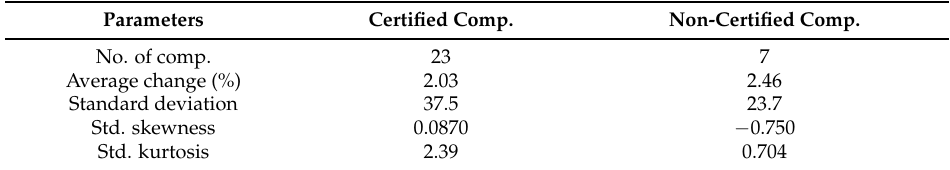
Table 5. Summary statistics on the change in electricity efficiency improvement in the period 1994–2006.